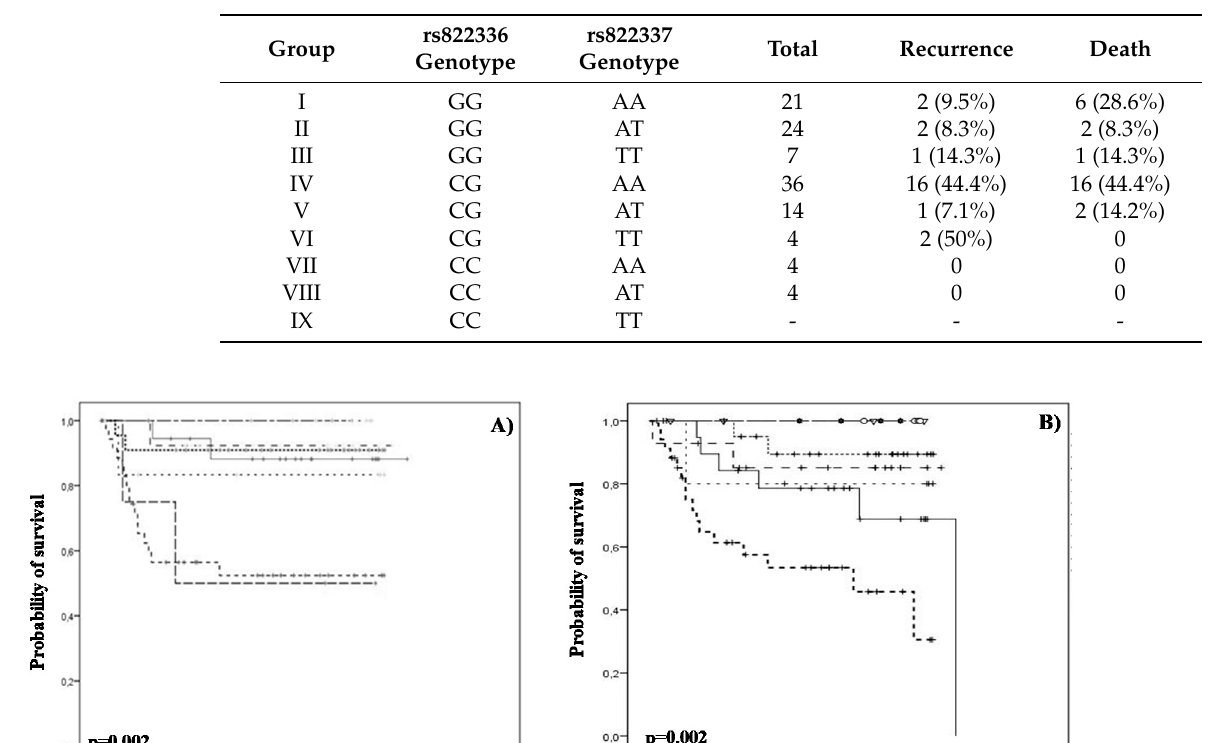
Table 4. Patient stratification based on the combination of the rs822336 G>C and rs822337 T>A genotypes.